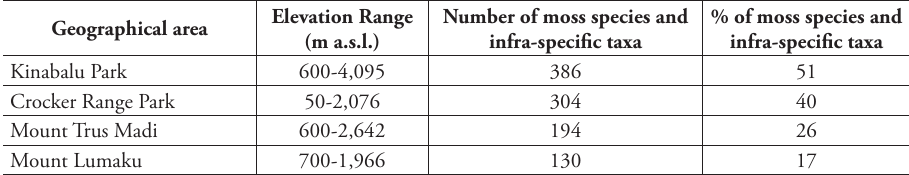
Table 4. Moss species and infra-specific taxa reported from mountainous areas in